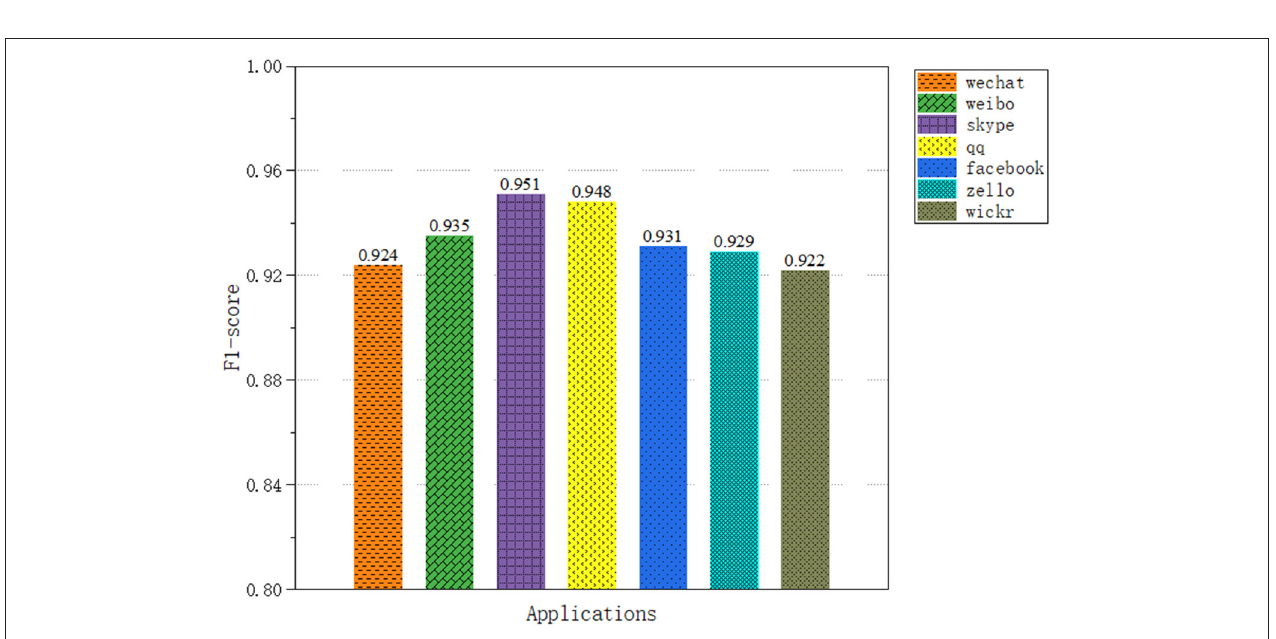
FIGURE 7 | Application classification results of LSTM neural